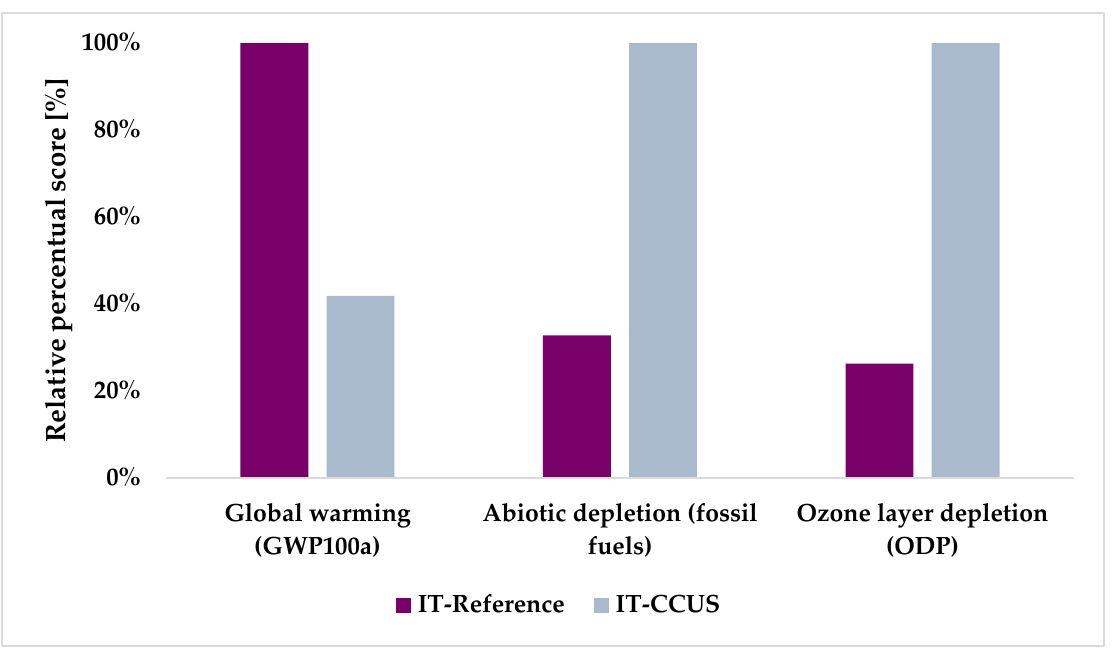
Figure 5. Impact category scores for the Italian case study in the CCUS scenario.